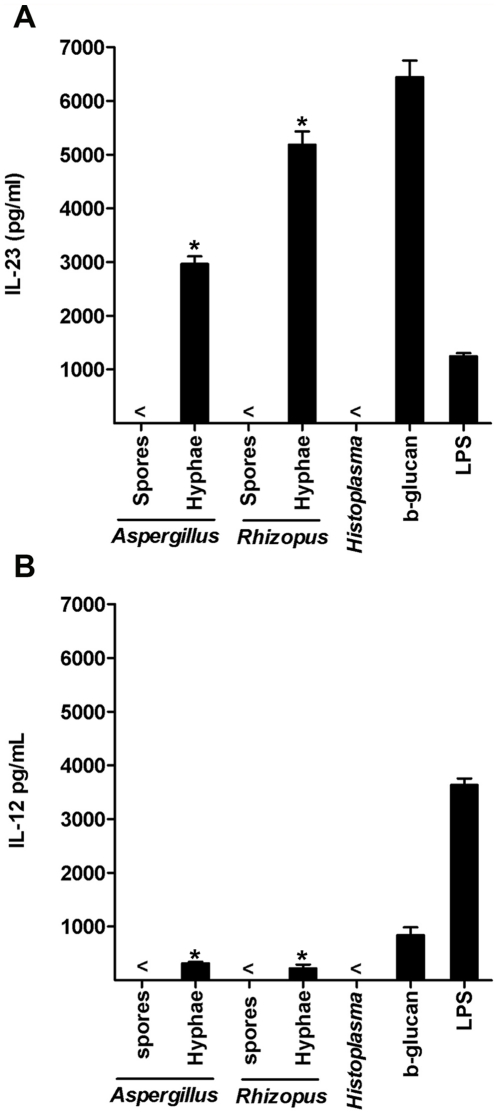
The invasive stage of growth of opportunistic fungal pathogens but not that of primary pathogenic fungi drives the induction of IL-23 producing DCs.IL-23 (A) and IL-12 (B) produced by human monocyte-derived DCs (1×106 cells per ml) following overnight stimulation with purified b-glucan (curdlan, 100 µg/ml), LPS (100 ng/ml), resting (spores) or invasive (hyphae) stages of growth of each opportunistic fungal pathogen (Aspergillus and Rhizopus) and the invasive form (yeast) of the pathogenic fungus Histoplasma, at a 1∶1 ratio. The results are representative of 6 independent experiments. < indicates that the measured value was below the detection limit of the assay (<20 pg/ml). Error bars represent SD. *, P<0.001, paired Student's t test.